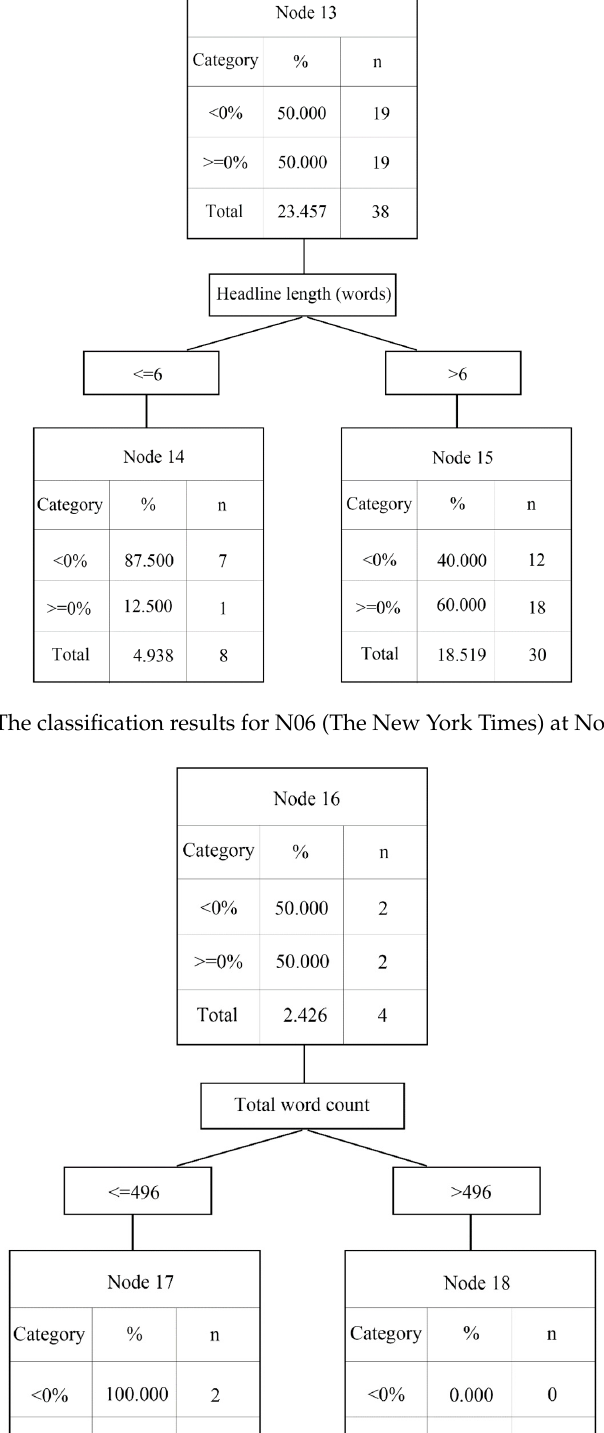
Figure 7. The classification results for N03 (The Wall Street Journal) at Node 9 and Node 10.